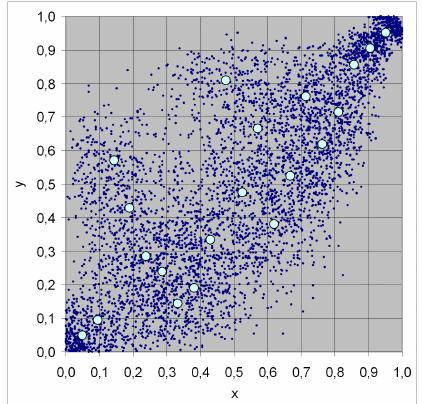
Figure 21: "Worst case" Poisson copula, a = b = 10